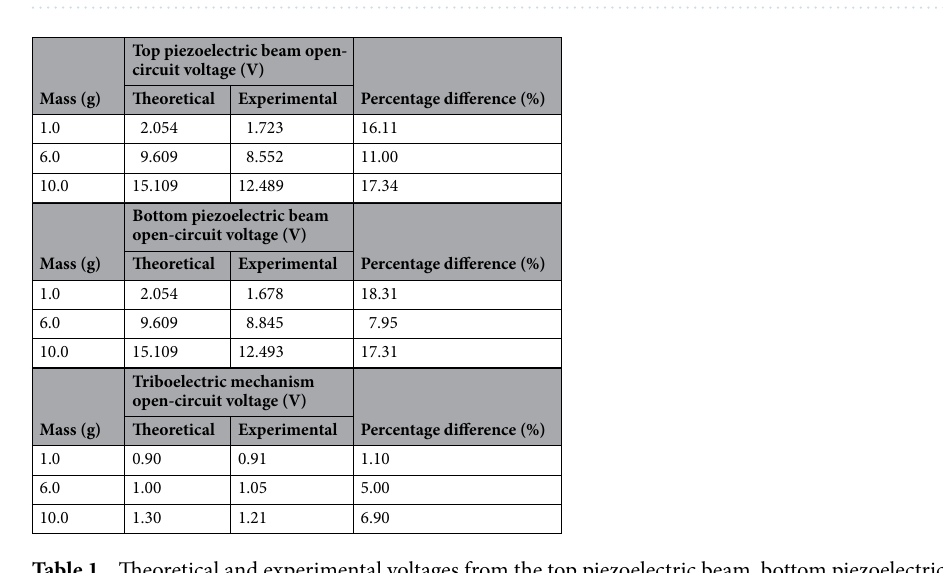
Table 1. Theoretical and experimental voltages from the top piezoelectric beam, bottom piezoelectric beam, and triboelectric mechanism for different mass placements.